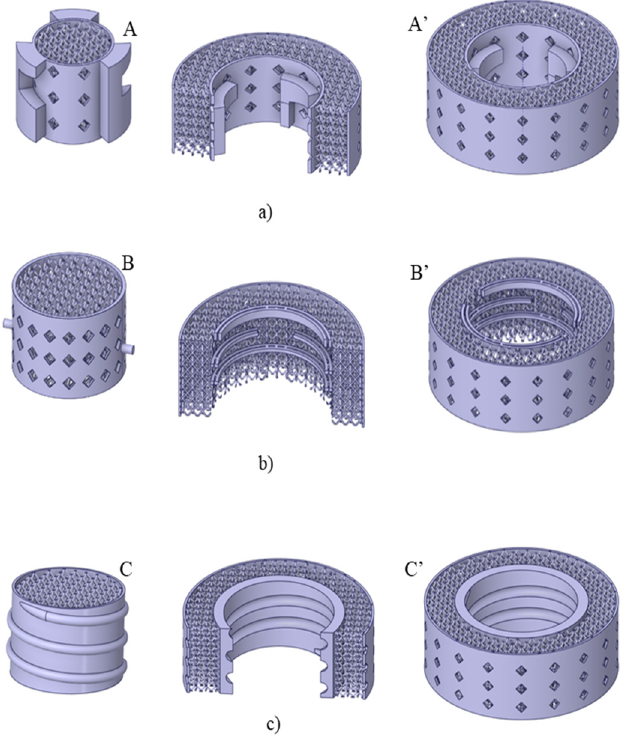
Figure 1. CAD models of the interlock designs, iso view of core and shell with cross-sectional shell view for ( a ) U-lock: core (A) and shell (A’); ( b ) Twist-lock: core (B) and shell (B’); ( c ) Thread: core (C) and shell